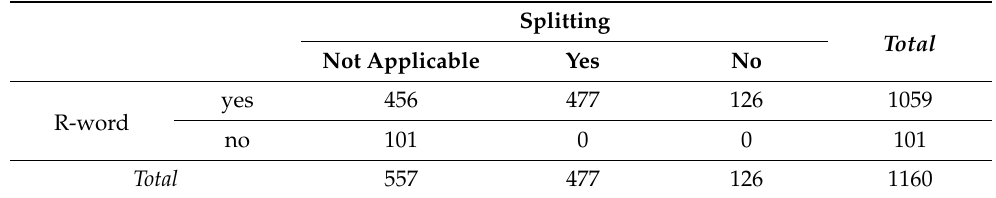
Table 3. The numerical relationship between the realization or non-realization of the R-word and the splitting of the PP containing an R-pronoun in the RoE data for groups C, D, M and T. Splitting Total Not Applicable Yes No yes 456 477 126 1059 R-word no 101 0 0 101 Total 557 477 126